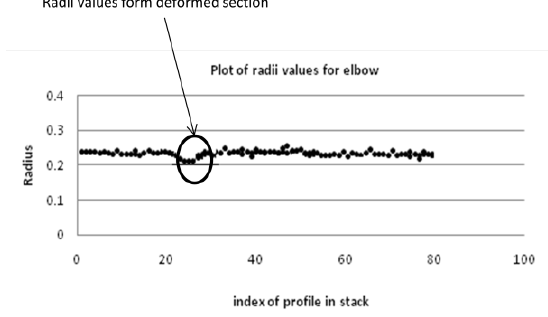
Figure 13. Radii values of pipe with deformation. A deviation from the true radii values is greater at the deformed section